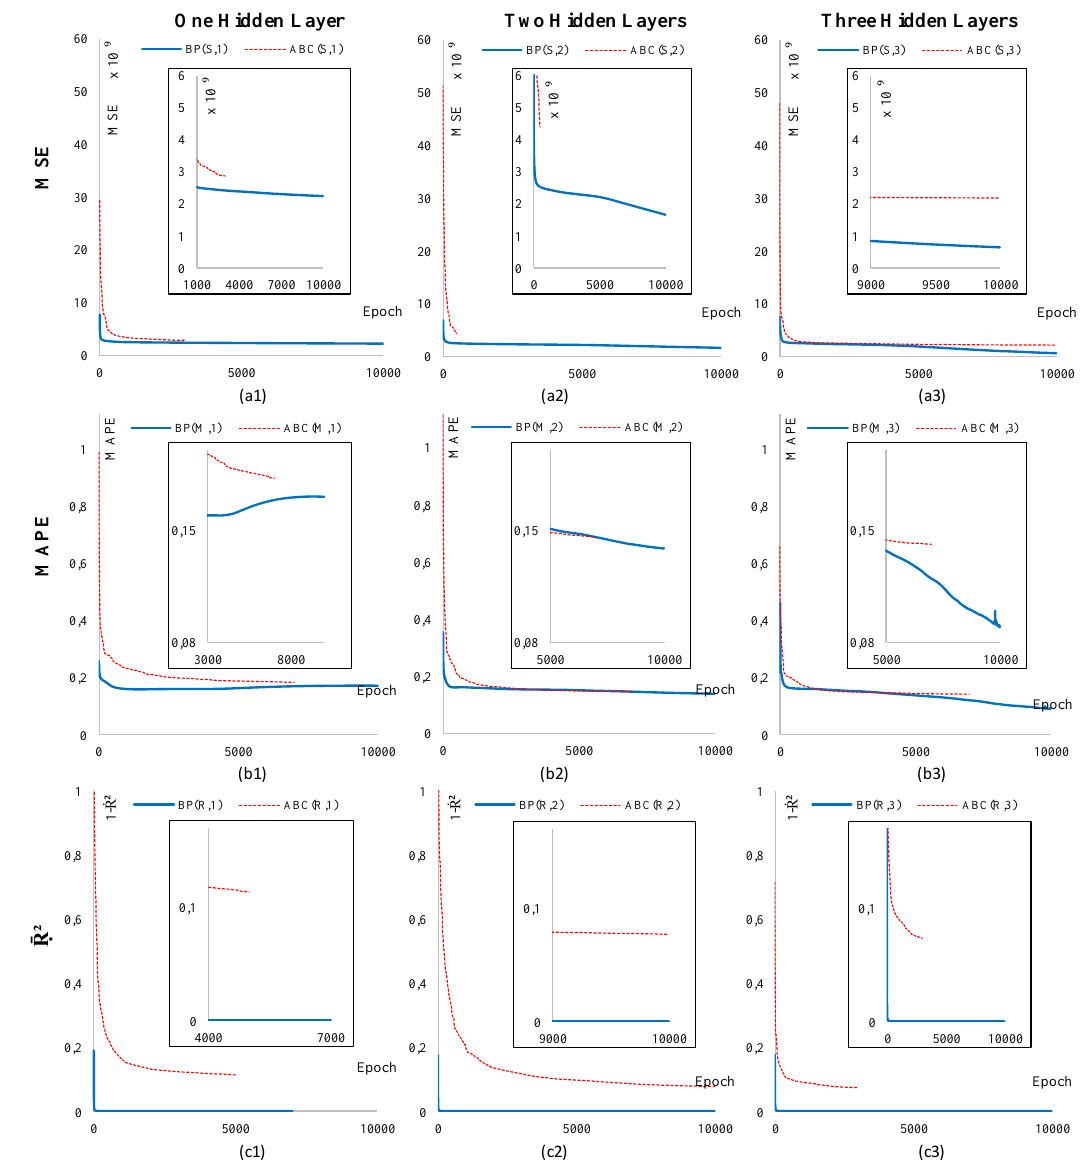
Figure 7. ANN training states with the lowest MAPEs (mean absolute percentage error). ( a ) Training with MSE (mean squared error); ( b ) Training with MAPE (mean absolute percentage error); ( c ) Training with ¯R. 2